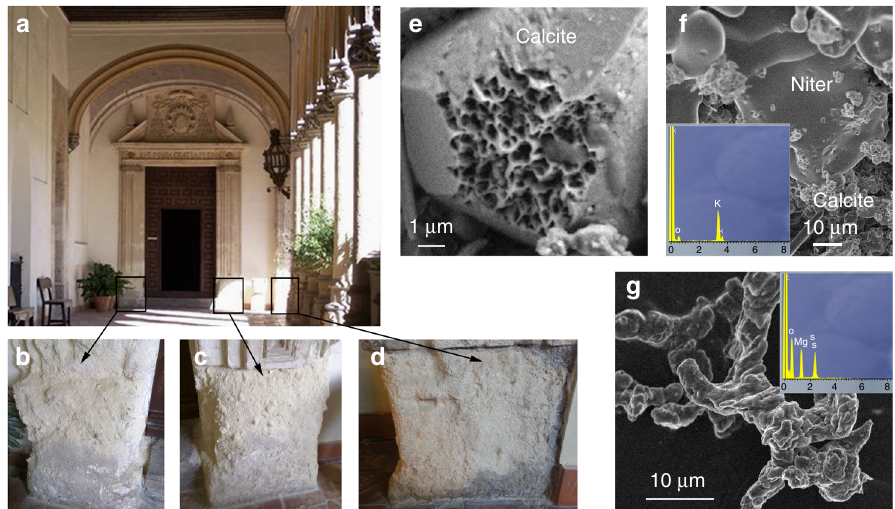
Fig. 1 Stone damage at the cloister entrance of San Jeronimo Monastery. a General overview. Detail of the stone blocks used for the bio-consolidation treatments: Myxococcus xanthus treatment ( b ), M-3P nutritive solution treatment ( c ), self-inoculation bio-treatment ( d ). Scanning electron microscopy (SEM) photomicrographs of corroded calcite ( e ), niter (KNO 3 ) (EDS spectrum in inset) ( f ) and hexahydrite (MgSO 4 · 6H 2 O) salt crystals ( g ) in the weathered calcarenite stone (EDS spectrum in